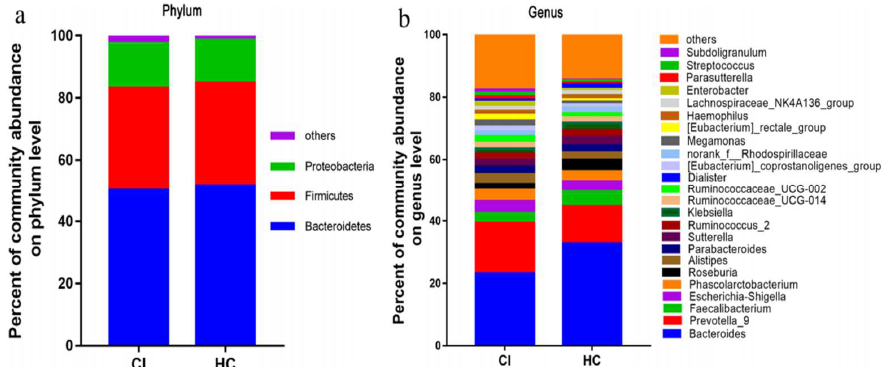
Figure 4. The relative taxa abundance between cerebral ischemic stroke patients ( n = 30) and healthy controls ( n = 30) belong to three phyla: Bacteroidetes, Firmicutes, and Proteobacteria ( a ) and to 25 genera that comprise up to 80% of the total microbiota, such as Bacteroides , Prevotell a, Faecalibacterium , Escherichia/Shigella , Phascolarctobacterium , and Roseburia ( b ). The figure is reused as per journal copyright permission [113].